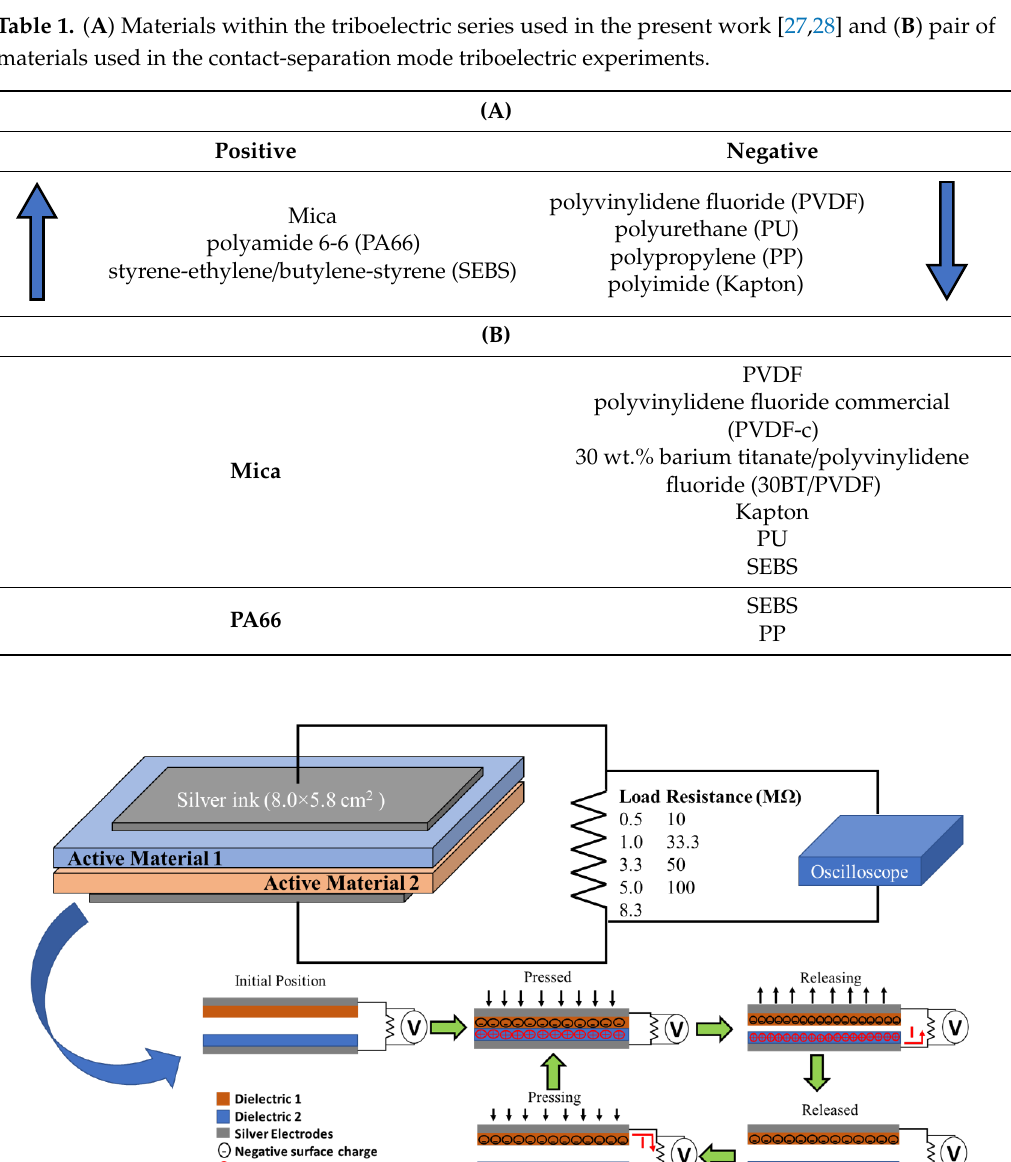
Table 1. ( A ) Materials within the triboelectric series used in the present work [27,28] and ( B ) pair of materials used in the contact-separation mode triboelectric experiments.